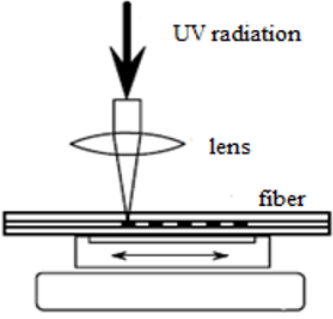
Fig. 3. Scheme of FBG recording by means of step-by-step approach.